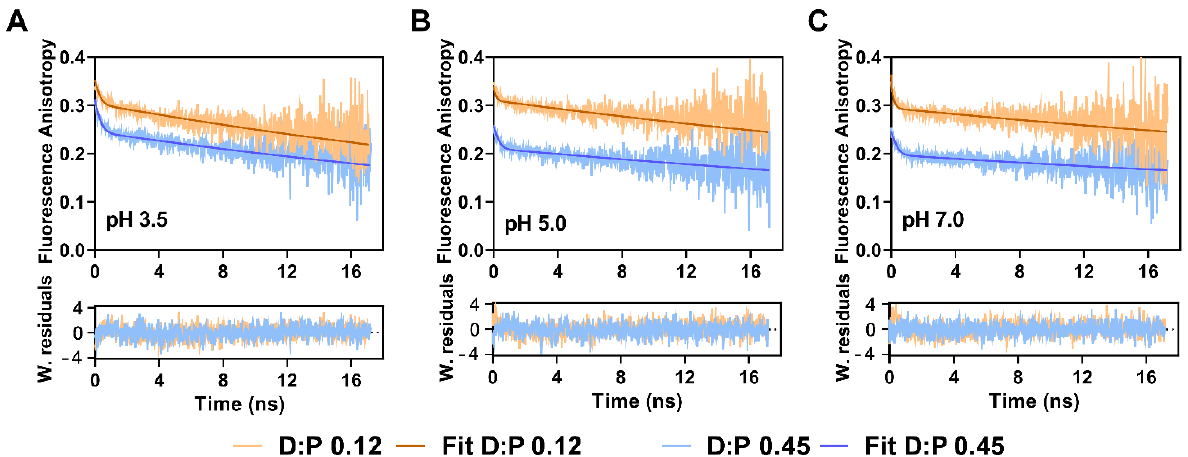
Figure 5. Representative fluorescence anisotropy decays of the TMR conjugated to G116C W67 KcsA protein at ( A ) pH 3.5, ( B ) pH 5.0, and ( C ) pH 7.0. The labeling ratio, D:P, of the samples was 0.12 (orange data) and 0.45 (blue data). The solid lines are the best fits of a double exponential function to the experimental data and the fitted parameters are summarized in Table 1. Bottom panels: the weighted residuals (W. residuals) are randomly distributed around zero showing the goodness of the fits. The measuring conditions were λ ex = 488 nm λ em = 575 nm. The buffers contained 5 mM DDM and 200 mM KCl (T = 25 °C). Table 1. Influence of pH and degree of labeling (D:P) on the fluorescence anisotropy decay parameters for TMR-labeled G116C variant of W67 KcsA. The amplitudes, β i and rotational correlation times, ϕ i , were obtained by global fitting of a two-exponential function to the data, i.e., by linking ϕ 2 between the anisotropy decay curves obtained for each pH at a low (D:P 0.12) and high degree of labeling (D:P 0.45) ( λ ex = 488 nm; λ em = 575 nm). The buffers contained 5 mM DDM and 200 mM KCl ( T = 25 °C).